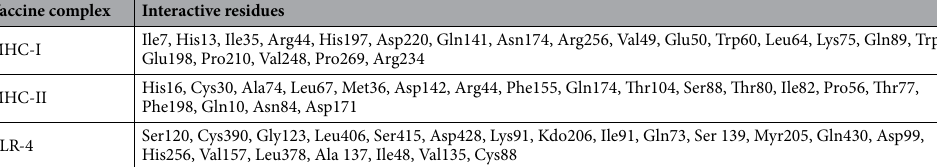
Vaccine complex